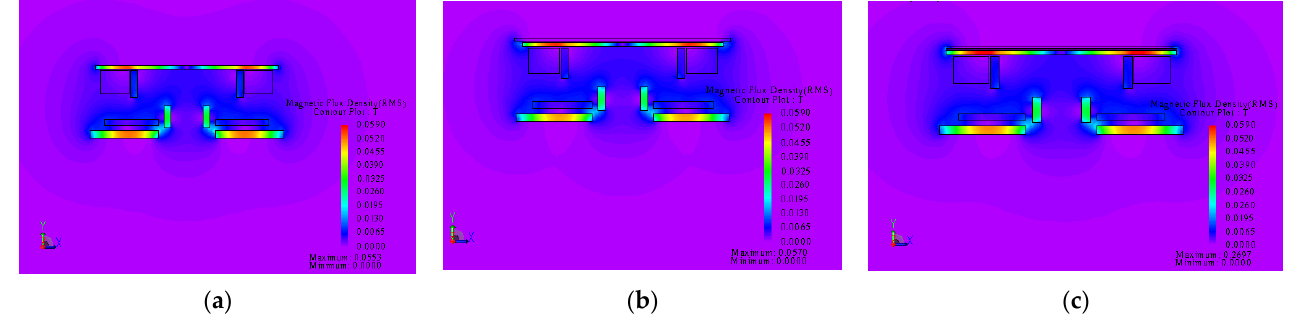
Figure 16. Cross-sectional magnetic flux density cloud images of different shielding structures. ( a ) Single-layer shielding structure; ( b ) double-layer shielding structure; ( c ) composite shielding structure.